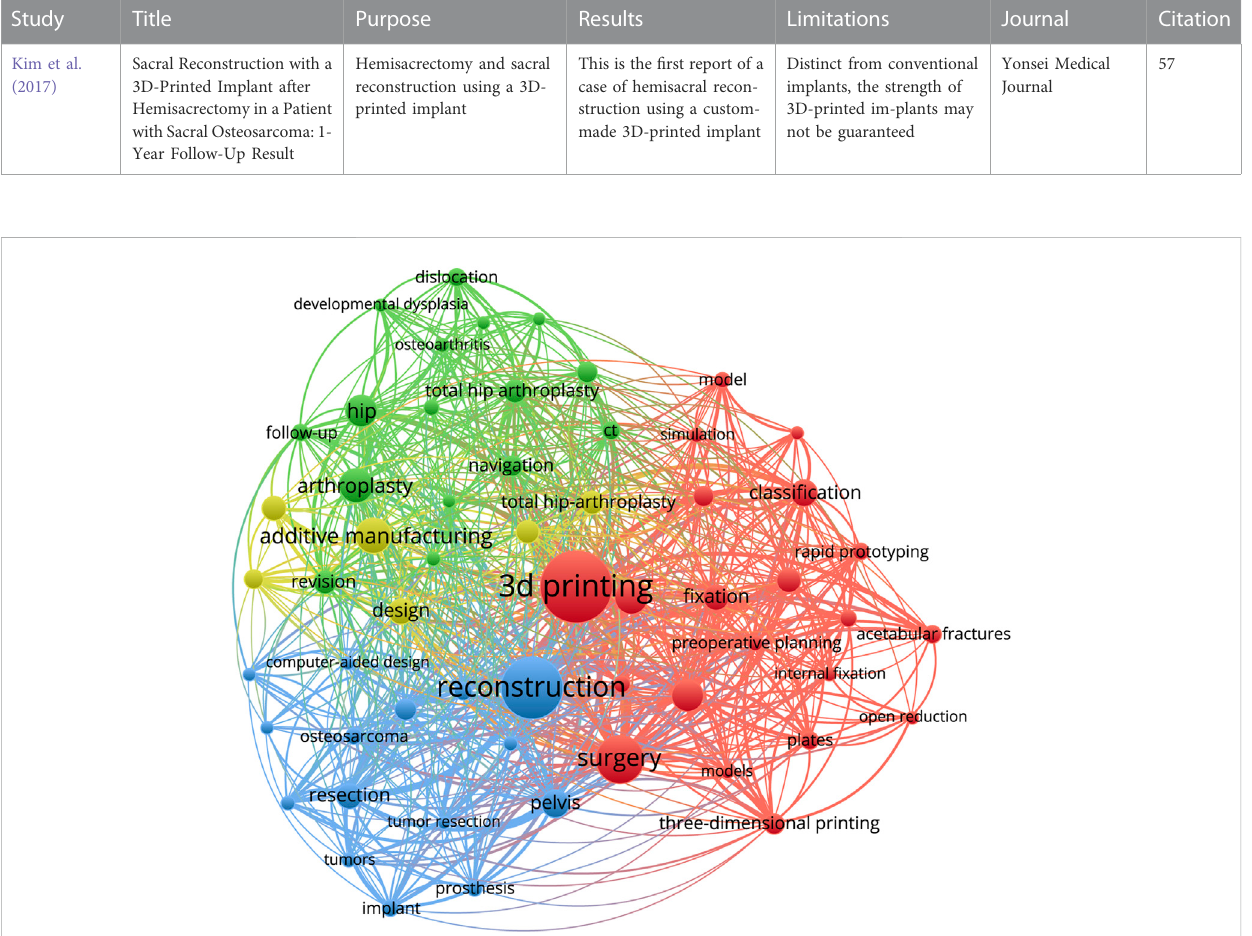
FIGURE 6 Network visualization of keywords. (The larger the bubbles are, the higher the probability of the keyword appearing. Then the more connections there are between the two bubbles, the more publications they appear in together, and the stronger the correlation will become. Furthermore, the different colors of the bubbles represent different clusters, implying that the keyword represented by the same color of bubble has a stronger